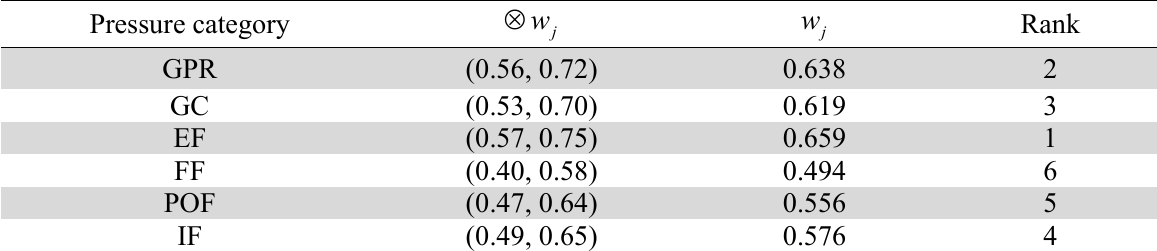
Pressures categories weight and